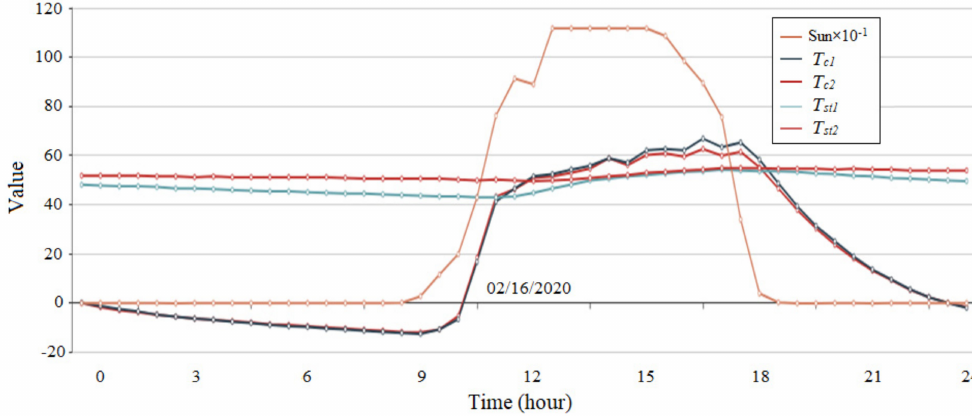
Figure 9. The typical variation in operating parameters of the solar hot water system in Kaftanchikovo village, Tomsk